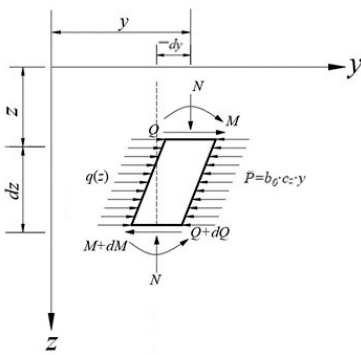
Figure 2. Schematic diagram for the stress analysis of a foundation pile.